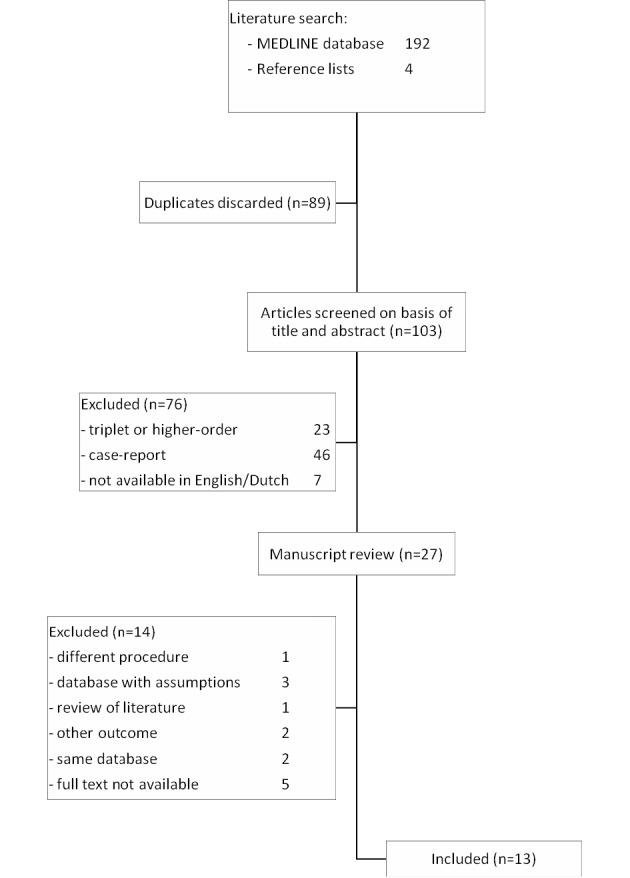
— Flow diagram of study selection